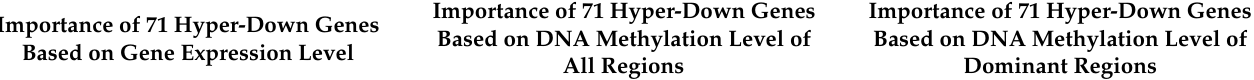
Table 4. Gene symbol and importance scores of 71 hyper-down genes in gene expression classifier and gene methylation